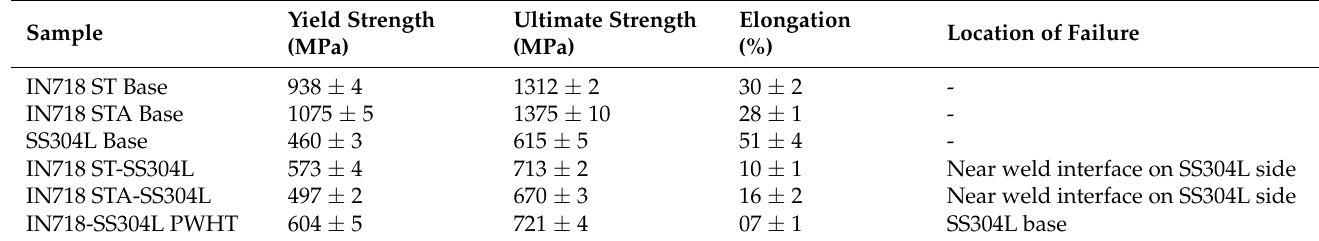
Table 5. Typical tensile data of the base metals and welded joints.